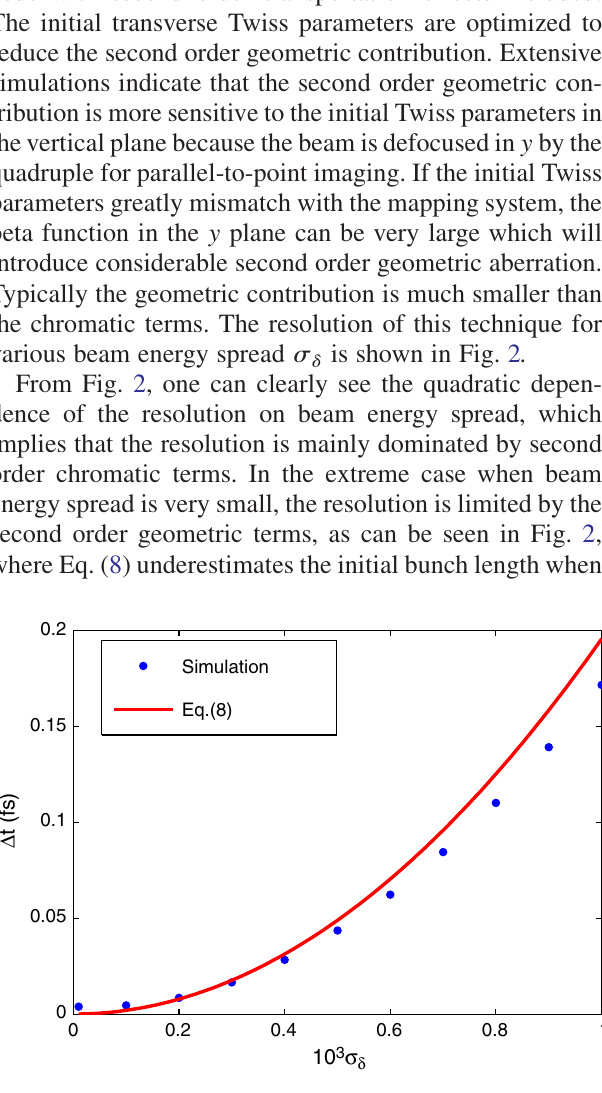
FIG. 2. Resolution in bunch length measurement: blue dots are the resolution determined from the beam size on the screen using ELEGANT simulation and the red curve is the results from Eq.